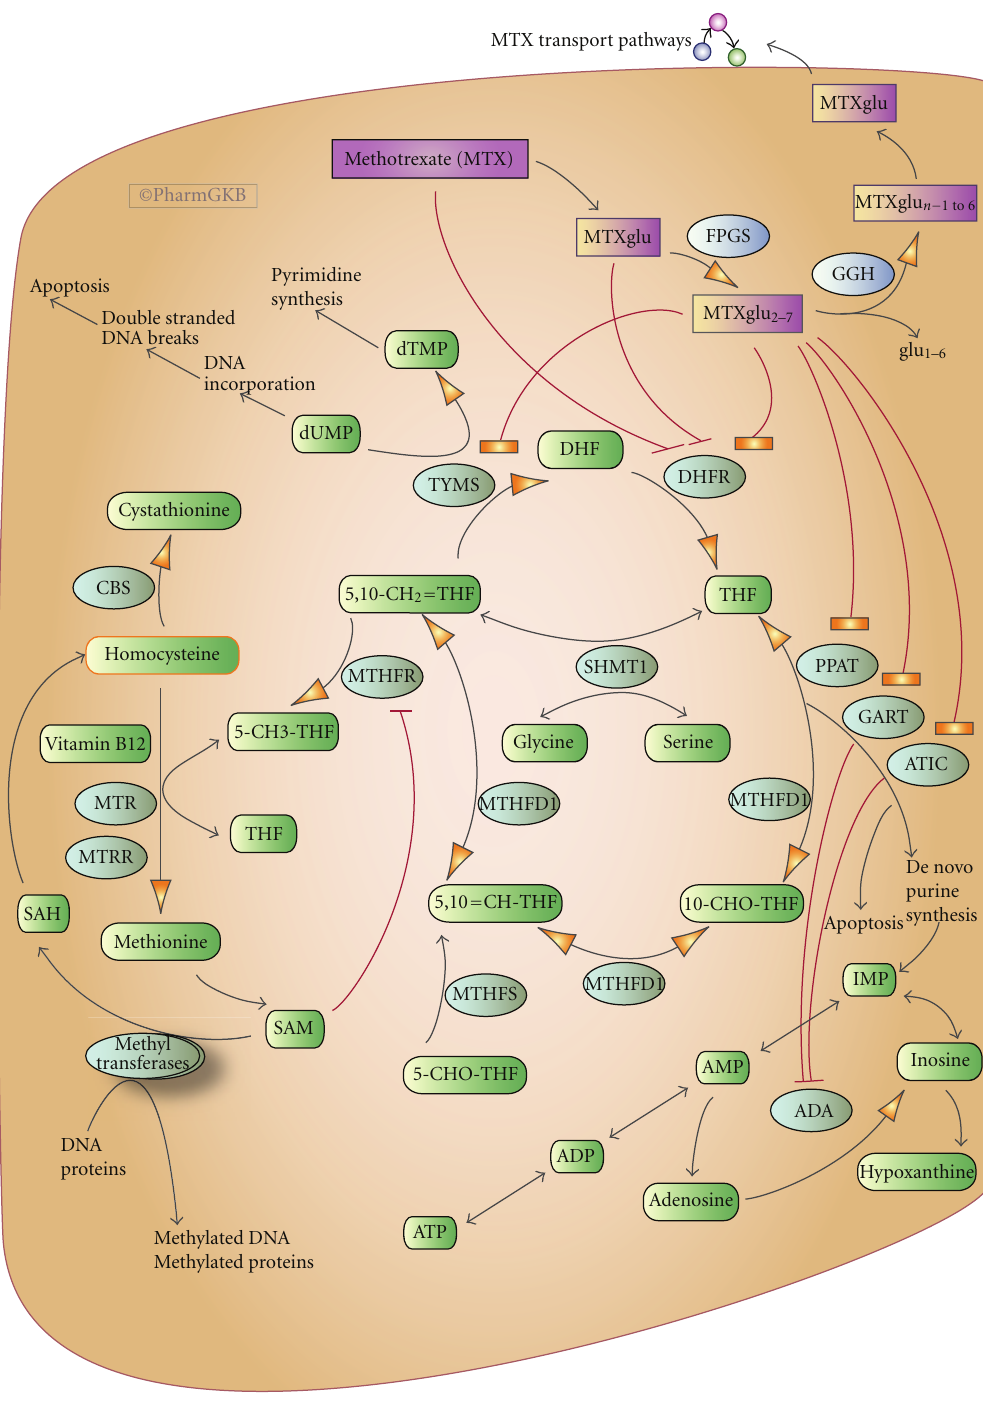
Figure 1: Methotrexate cellular disposition and e ff ects from reference [9]. Copyright PharmGKBu, Used with permission from PharmGKB and Stanford